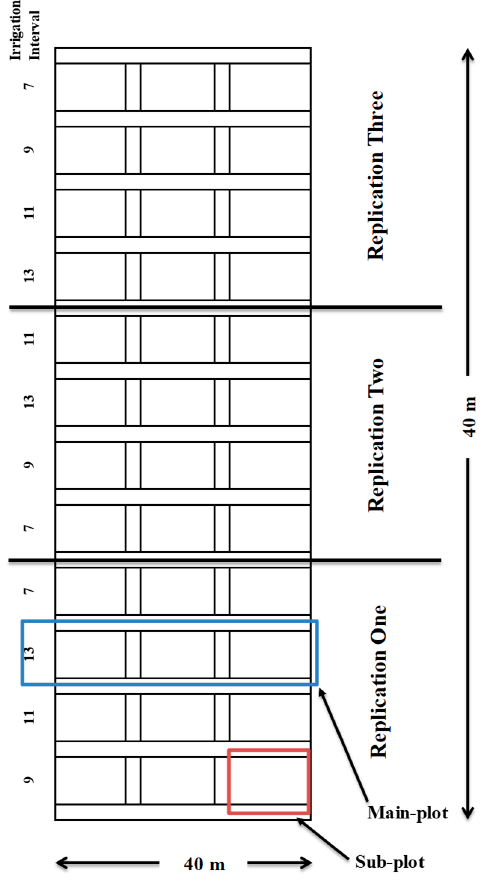
Figure 1. Split-plot experimental design with main plots and sub-plots, 2011 and 2012.